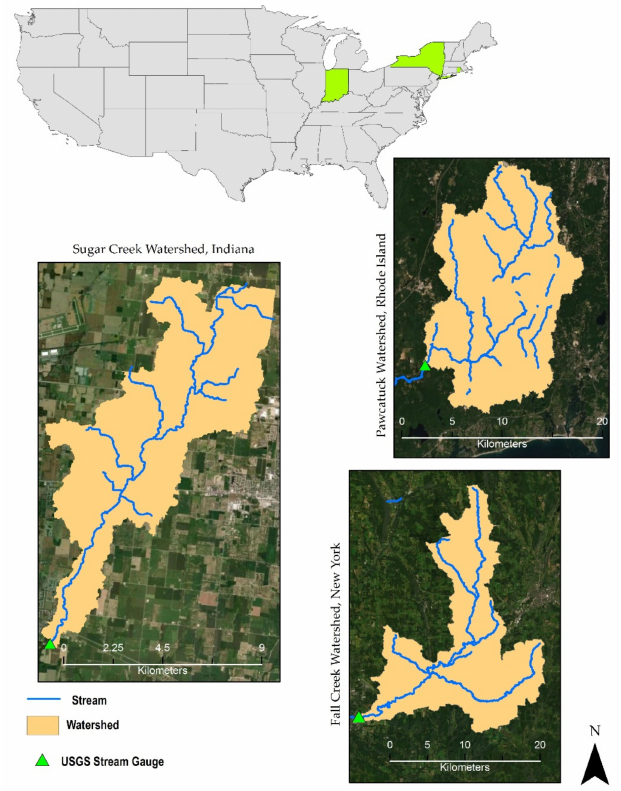
Figure 1. Three Study